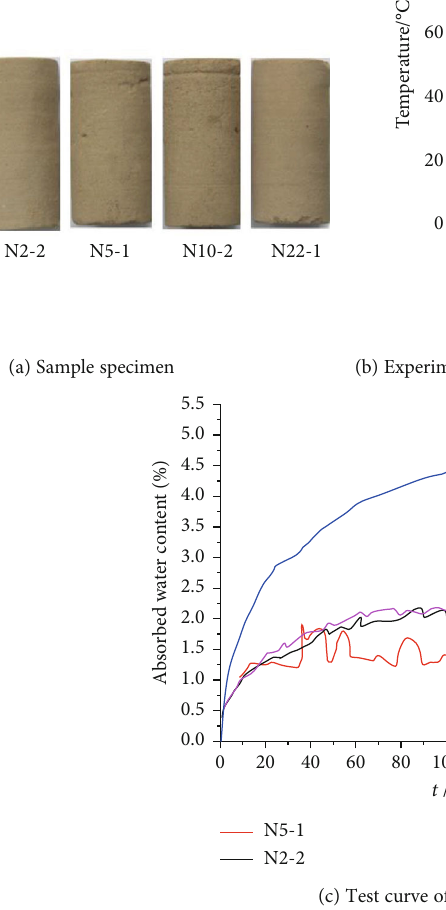
Figure 30: Simulation experiment of the surrounding rock wall of mudstone supporting body in Mogao